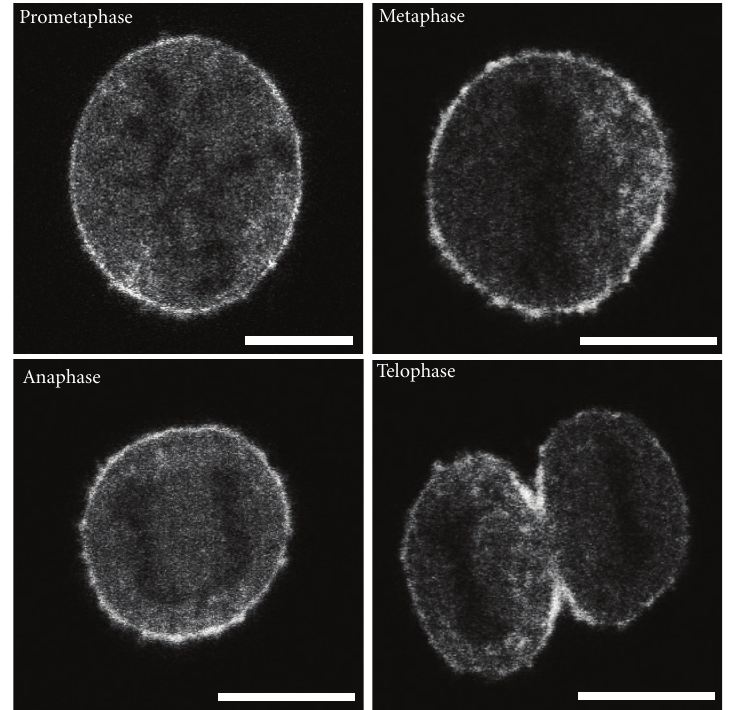
Figure 4: The F-actin cortex is maintained during division of PC12 cells. Actin-GFP was expressed in PC12 cells and dividing cells were imaged by confocal microscopy. Single focal planes through the middle of the cells are shown for di ff erent stages of cell division as indicated. Notably, through all phases of mitosis a pronounced peripheral, ribbon-like accumulation of actin-GFP was observed, indicating that the F-actin-rich cortex remained intact. Scale bar, 10 μ